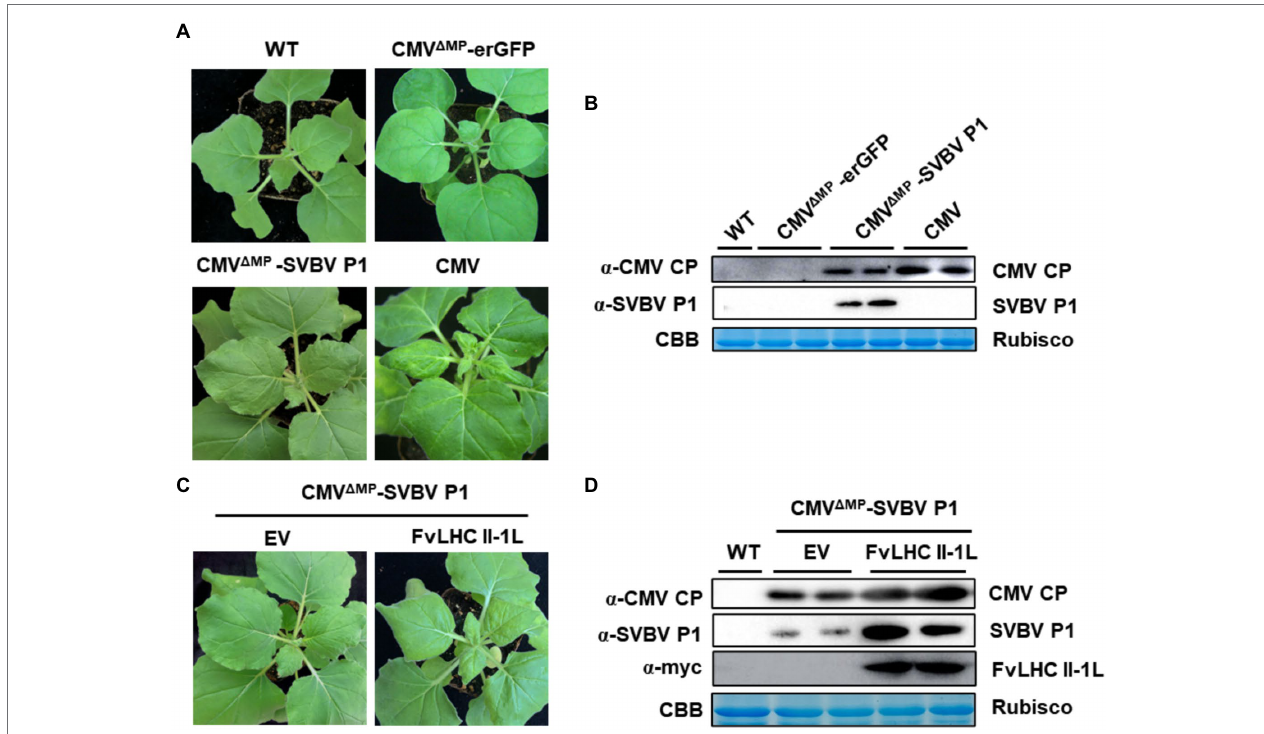
FIGURE 5 | FvLHC II-1L assists SVBV P1 in complementing movement-defective cucumber mosaic virus (CMV). (A) Systemic symptoms of wild-type N. benthamiana plants agroinfiltrated with CMV, CMV Δ MP -erGFP, or CMV Δ MP -SVBV P1 at 8 dpi. WT indicates non-infiltrated plants that served as the negative control. (B) Accumulation of CMV coat protein (CP) and SVBV P1 in systemically infected leaves was detected via western blotting. (C) Systemic symptoms of empty vector (EV) or FvLHC II-1L transgenic N. benthamiana plants agroinfiltrated with CMV Δ MP –SVBV P1 at 8 dpi. (D) Accumulation of CMV CP, SVBV P1, and FvLHC II-1L in systemically infected leaves was detected via western